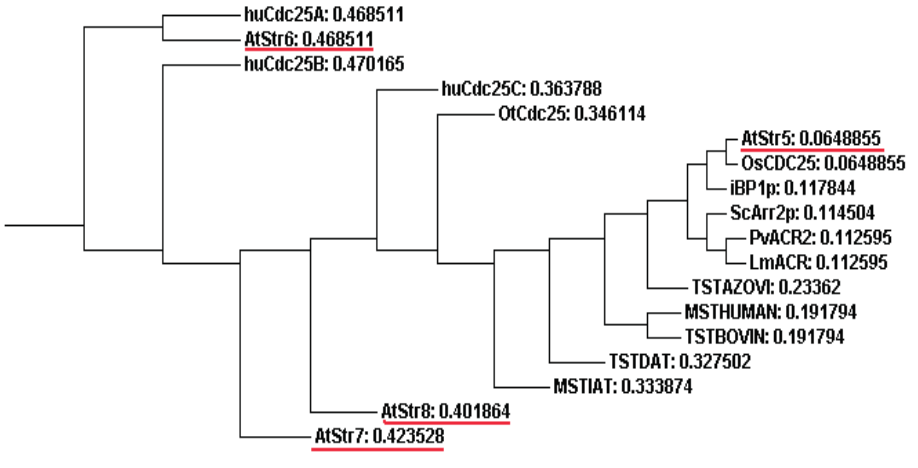
Figure 4. Phylogenetic tree obtained by using the Neighbor Joining method. The sequences selected for phylogenetic analysis are: Human Cdc25A (huCdc25A; NP_001780.2),